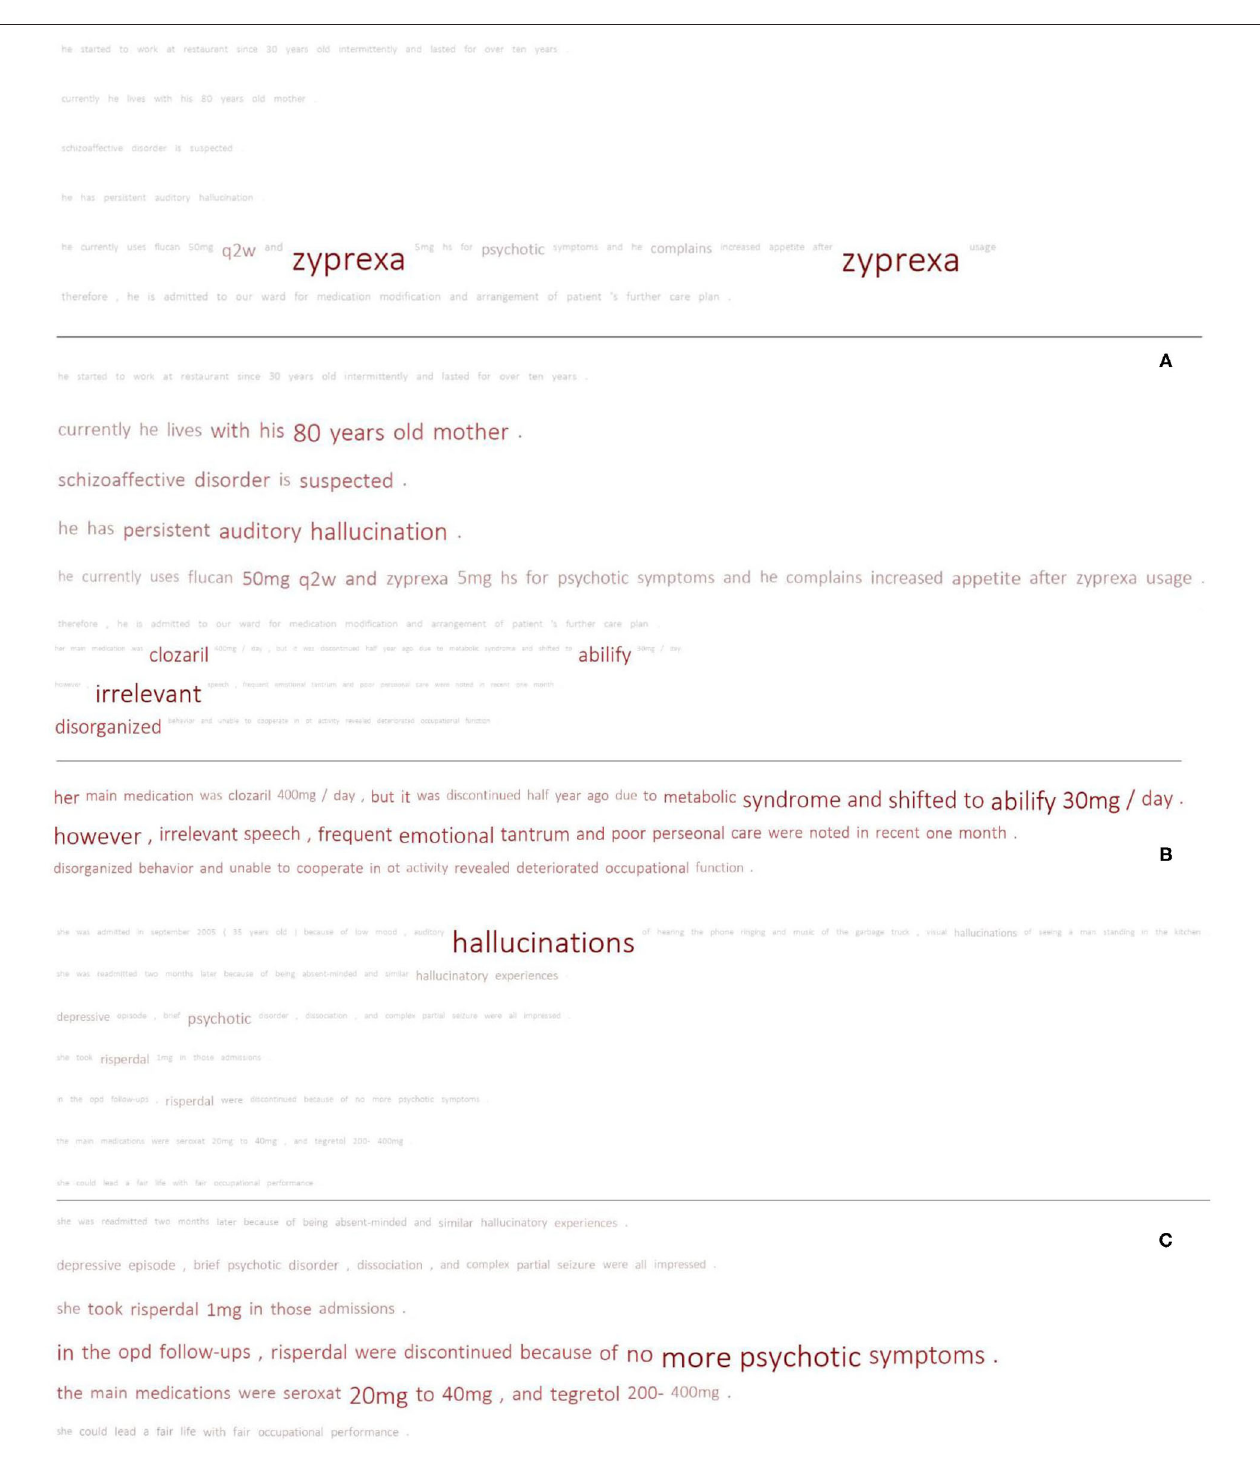
FIGURE 7 | Comparison of the results of the pre-trained model and random initialization. Each sub-figure compares the results of HAN-glove_FD (upper) and HAN-rand_FD (lower). (A) TP vs. FN; (B) TP vs. TP; (C) FP vs. FP. with the approach that identifies the major depressive cases by using the number of observed depressive symptoms